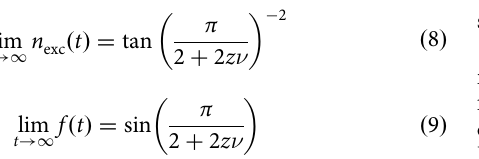
Fig. 2 Characterisation of quantum adiabatic cycles. a Heat generated during a gapped cycle with time-dependent gap ω ð t Þ 2 ¼ t 0 þ δ j t j gap ω 0 ¼ t 2 z ν , drive rate δ and scaling exponent z ν . The curves are shown as a function of the time t in units of t * ∝ δ − z ν /(1 + z ν ) . Notice that the minimal gap 0 ω t 0 is reached at the time 0 . Each sub-panel reports various curves for increasing values of direction of the arrow. The generated heat vanishes in the large s 0 limit. b The fi delity of the model for different values of z ν = {0.5, 0.9, 1.3, 1.75, 2.2, 3} (solid lines from top to bottom) is compared with the asymptotic result in Eq. (9) (dashed horizontal lines). c The numerical results for the number of excitations, de fi ned by Eq. (12) in the Supplementary Methods 1, have been calculated within the generalised dynamical model described by Eq. (10). Different values of γ ∈ [0, 0.01], which quantify the extent of the non-universal correction see Eq. (10), produce different curves for t > t * (solid lines). However, the long-time limit converges to the same asymptotic value. The exact analytic solutions at γ = 0 are shown as black dashed